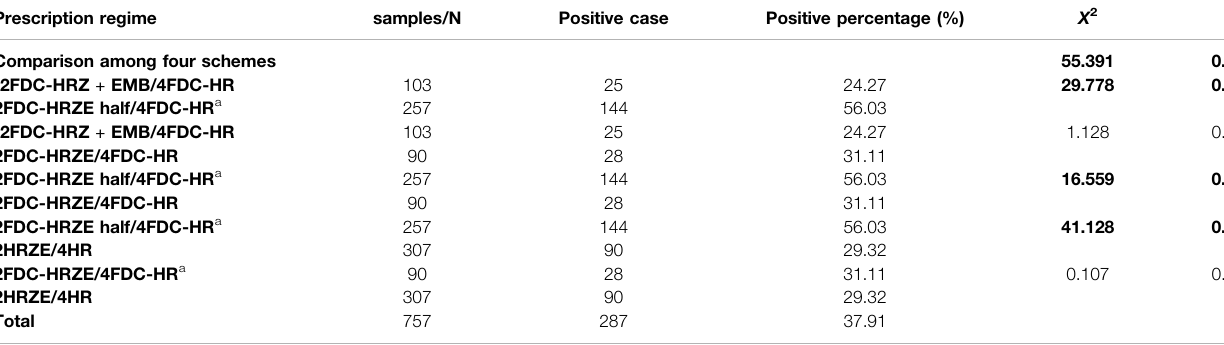
TABLE 4 | Different drug prescriptions in TB patients and positive rate distribution. Prescription regime samples/N Comparison among four